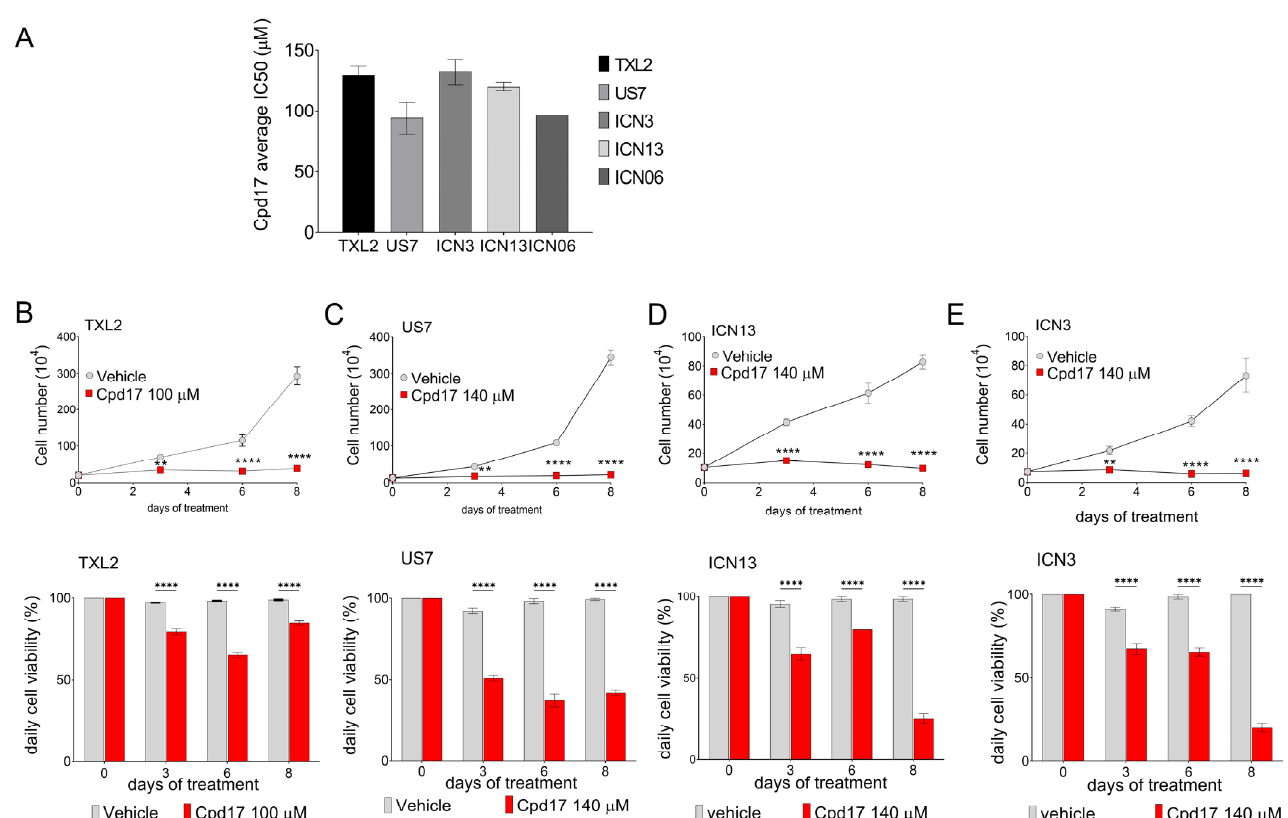
Figure 7. Determination of IC 50 values for Cpd17. ( A ) For IC 50 determination, cells were incubated with different concentrations of Cpd17 for three days without OP9 cells. Cell counts were done using Alamar blue. Error bars, mean ± SEM of independent triplicate IC 50 determinations. ( B – E ) Different ALLs as indicated were co-cultured with OP9 cells for eight days and treated with ≈ IC 50 concentrations of Cpd17. Top panels, cell numbers; lower panels viability determined by Trypan blue exclusion. Representative results from three independent experiments. Note: cell viability is defined here as the number of Trypan blue excluding cells in Cpd17 treatment group/number of Trypan blue excluding cells in group treated with solvent DMSO at each time point. Error bars, mean ± SEM of triplicate samples. Two-way ANOVA, Šidák’s multiple comparison test. Each point compares vehicle to Cpd17 on the same day. ** p < 0.01, **** p < 0.0001.